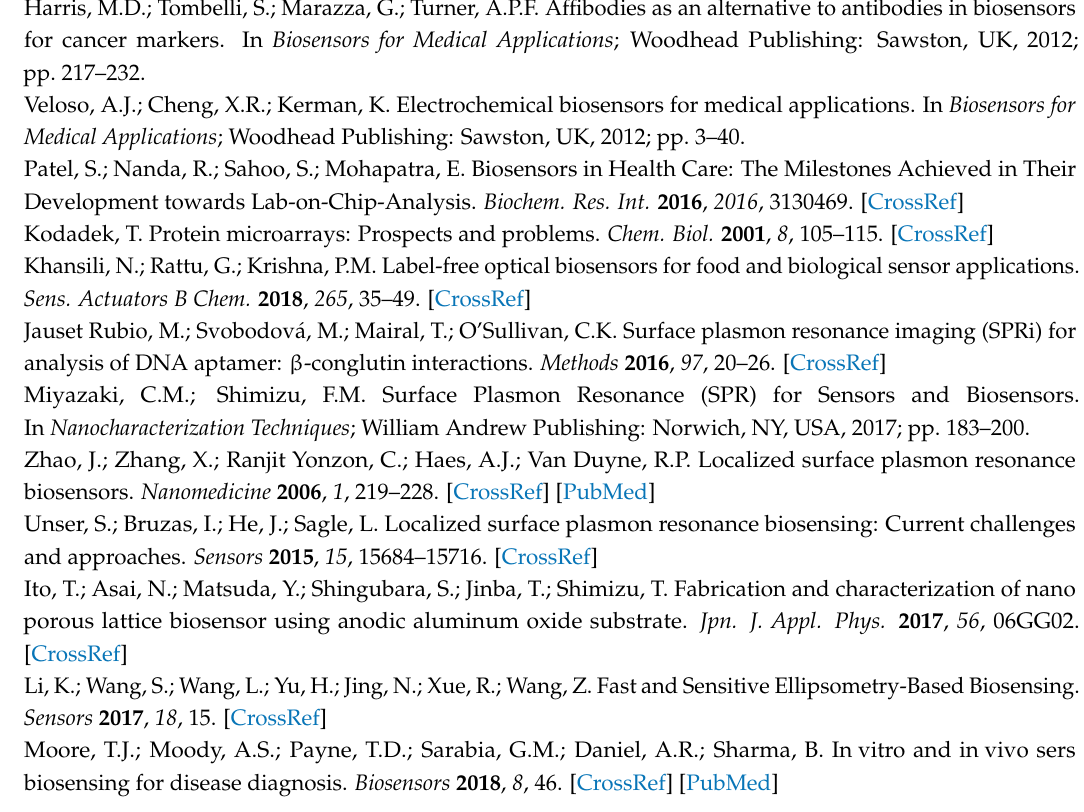
Figure S1: SEM images of NAA, Figure S2: Registered change in EOT as a function of time in entire experiments for different pore diameter, Figure S3: Best replicates of all the experiments for different concentrations of biotinylated